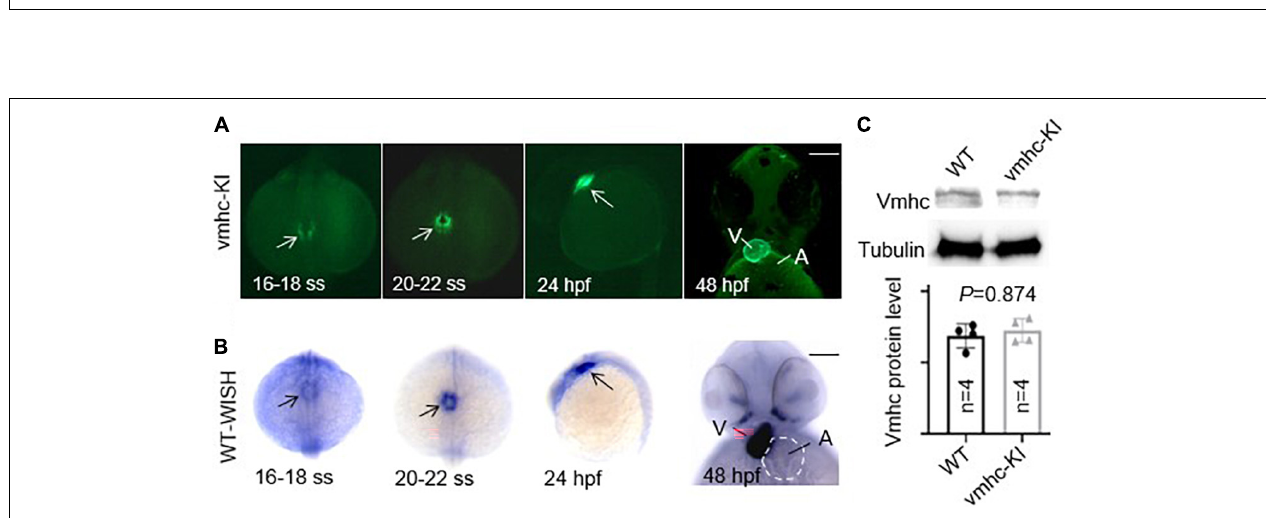
FIGURE 2 | Enhanced green fluorescent protein in the vmhc KI − EGFP zebrafish KI line recapitulates endogenous expression patterns of the vmhc gene. (A) EGFP patterns in the vmhc KI − EGFP KI fish line from 16 to 18 somite stage (SS) to 48 hpf. Scale bar, 100 µ m. White arrows point to specific patterns of the EGFP signal. (B) Endogenous expression patterns of the vmhc gene from 16 to 18 somite stage (SS) to 48 hpf revealed by WISH. Black arrows point to the specific expression pattern of vmhc endogenous transcripts. The dotted line outlines the shape of the atrium. Scale bar, 100 µ m. (C) Western blotting and quantification analysis of the Vmhc protein expression in the vmhc KI − EGFP KI fish line compared to wild-type (WT) control. N = 4. Unpaired 2-tailed Student’s t -test. V, ventricle. A, atrium.